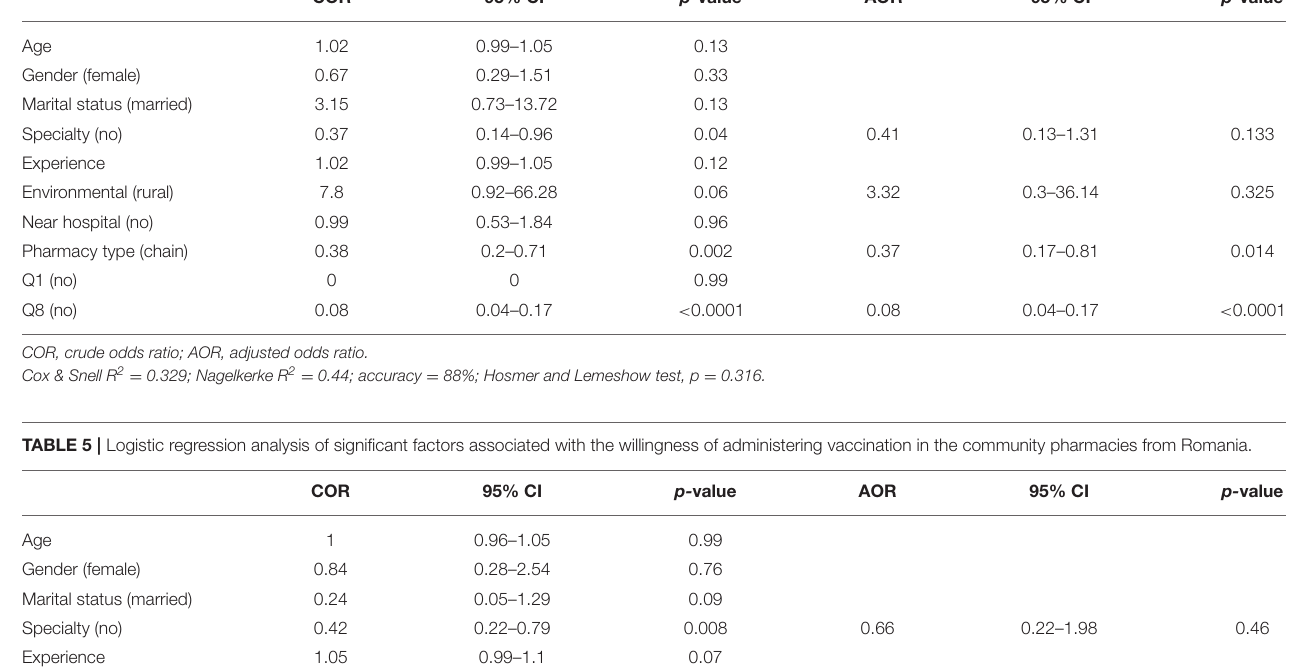
TABLE 4 | Logistic regression analysis of significant factors associated with the willingness of administering vaccination in the community pharmacies from Bulgaria. COR 95% CI